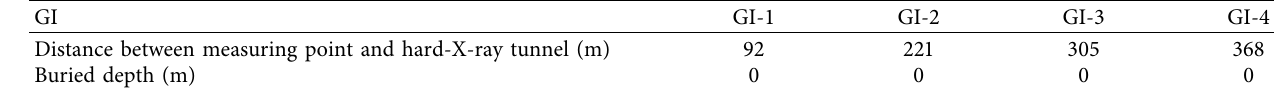
Table 1: Positions of measurement points in the first group of tests. GI